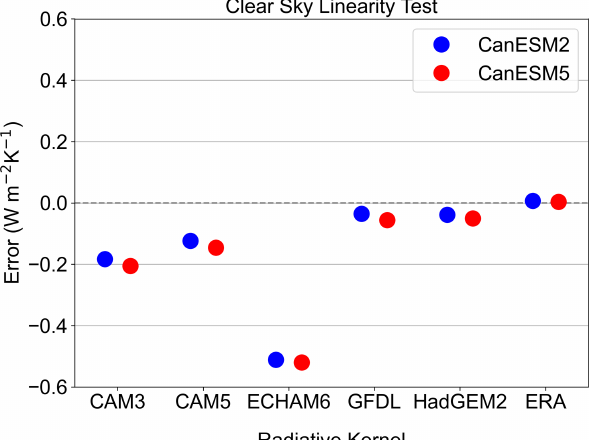
Figure A1. Clear-sky linearity test for six sets of radiative kernels considered in this study (CAM3, CAM5, ECHAM6, HadGEM2, and ERA kernels) tested using each version of CanESM. The y axis error is defined as the absolute difference between the Gregory-regression-derived net clear-sky climate feedback parameter and radiative-kernel-derived net clear-sky climate feedback parameter.